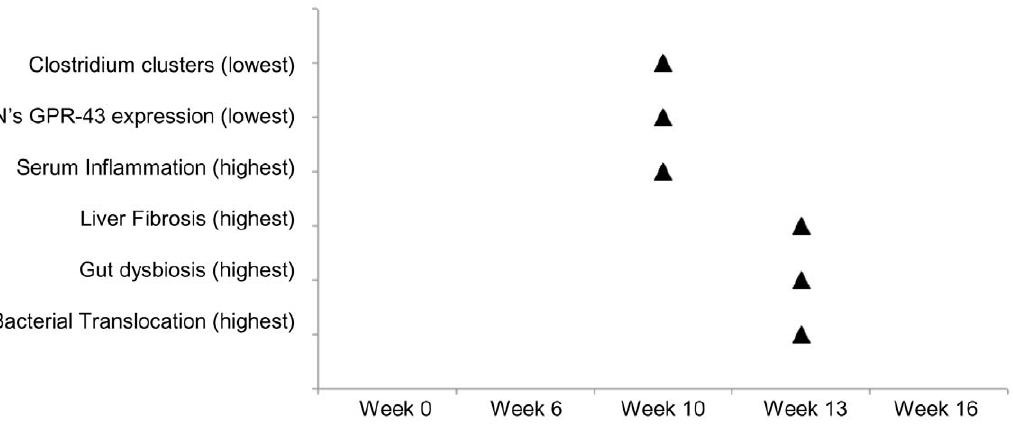
Figure 5. Temporal pattern of key events related with development of bacterial DNA translocation in CCl 4 -treated mice. The lowest levels of cytokine production, PMN butyrate specific-receptor GPR43 and Clostridium clusters counts from samples of intestinal cecum content along with the highest degrees of liver fibrosis, gut dysbiosis and bacterial translocation observed in treated animals are chronologically represented during the 16 weeks of study protocol.